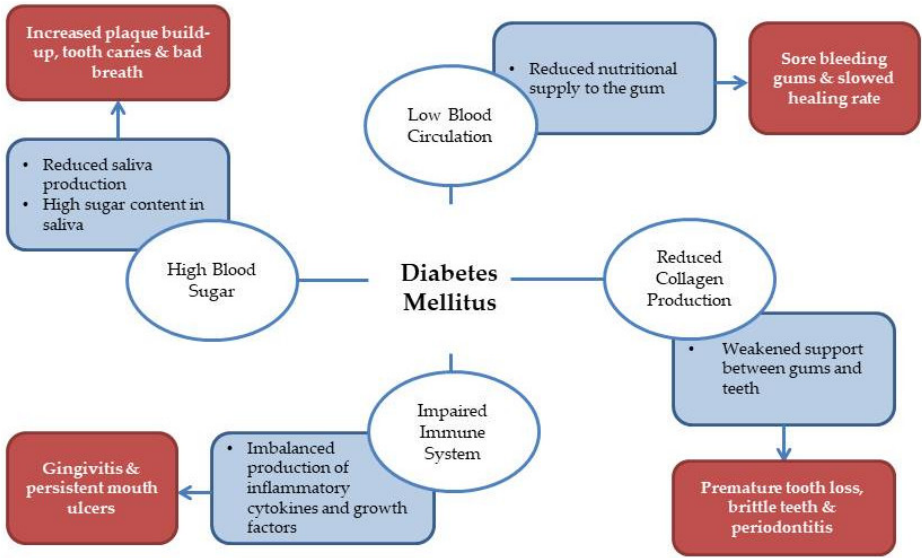
Figure 3. Common reasons as to why diabetics are prone to developing oral health issues.